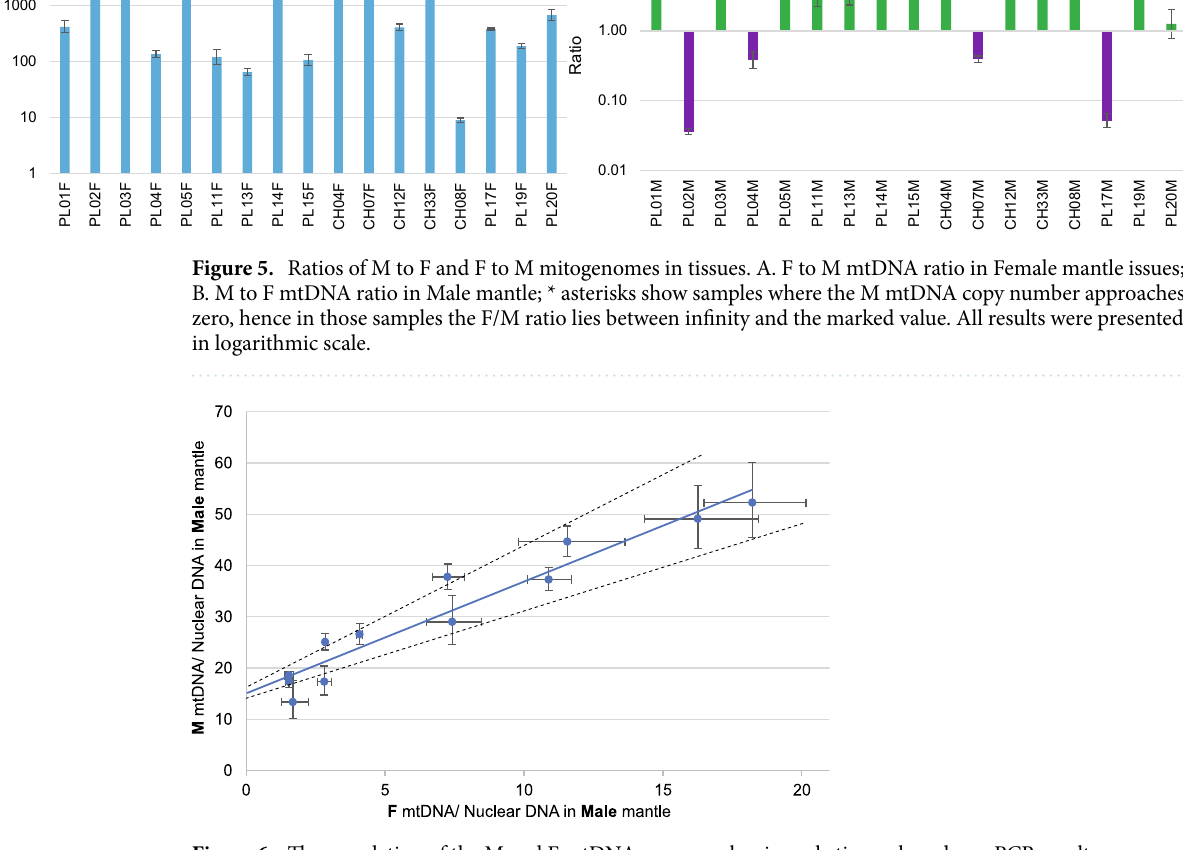
Figure 6. The correlation of the M and F mtDNA copy number in male tissues based on qPCR results. Intersection of the regression line with the Y axis marks predicted copy number of M mitogenomes in single sperm cell. Dotted line shows standard